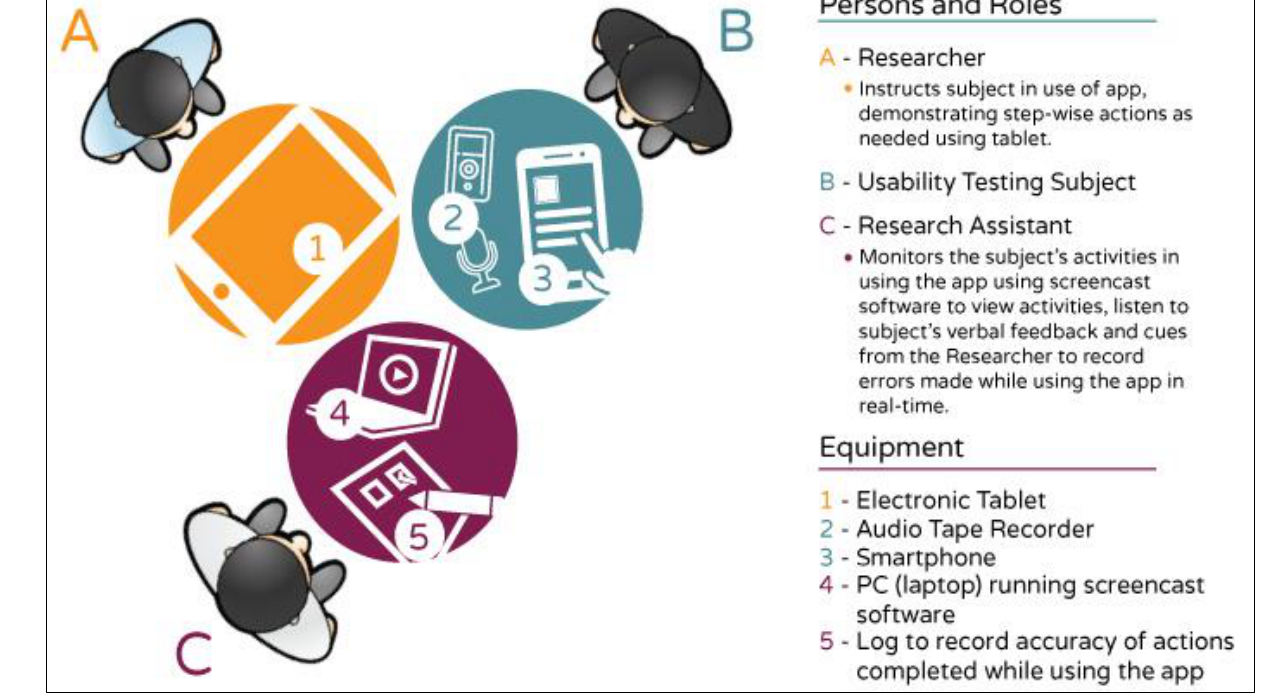
Figure 2. The physical arrangement of the usability testing set-up during Phase I. The research subject was provided a smart phone to utilize the app modules. The researcher provided visual and/or verbal instructions and assistance (if needed) using an electronic tablet. Usability data was gathered via audio recording as well as from a research assistant who was able to monitor the participants’ actions with a laptop screen running screencast software. Impor tantly, the research assistant was seated across from the participant in order that he or she could observe and document performance without making the participants uneasy or aware of initial